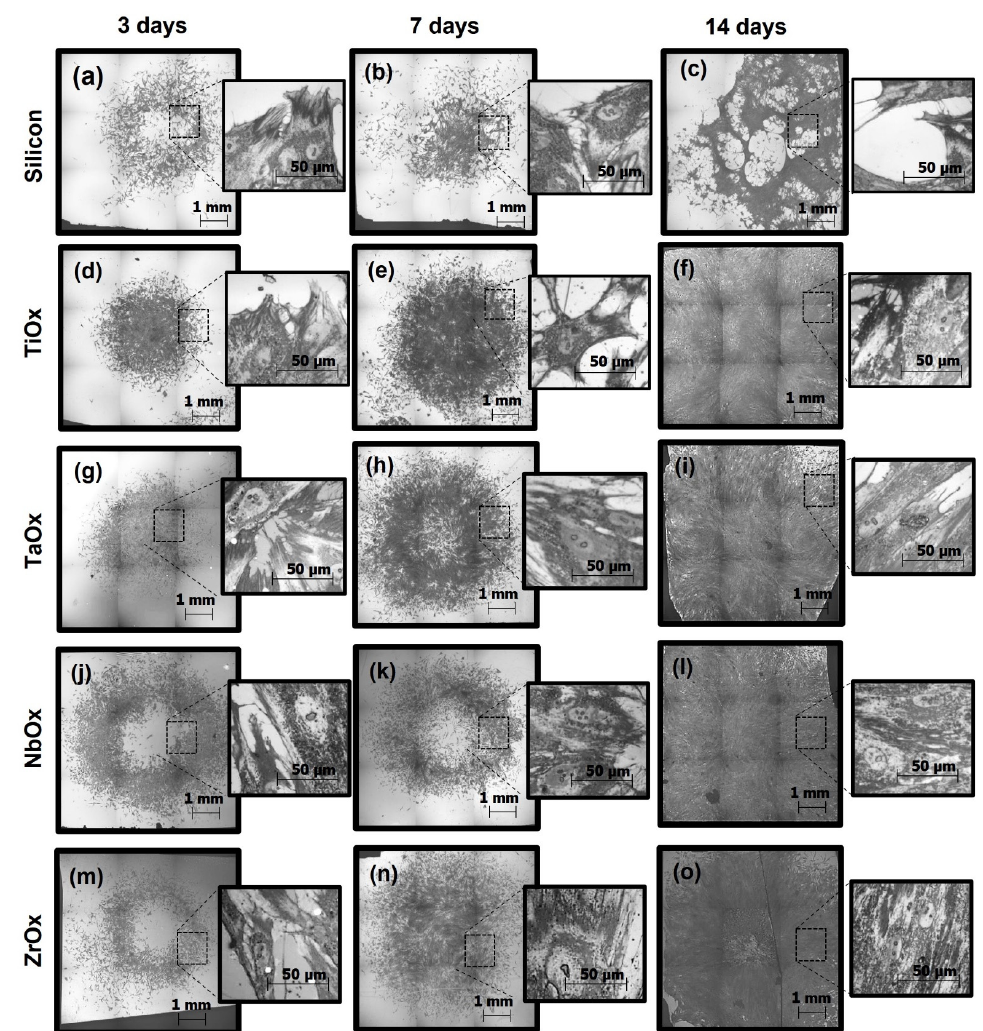
Figure 5. Representative micrographs, obtained by an optical profilometer, of BM-MSC cell cultured on uncoated Si ( a – c ) and coated, TiOx ( d – f ), TaOx ( g – i ), NbOx ( j – l ), and ZrOx ( m – o ), samples. Three incubation times were handled, 3, 7, and 14 days. Micrographs were acquired at two different mag- nifications, 5× for main micrographs and 50× for insert magnifications. Figure 6 presents a qualitative evaluation of cell viability by the LIVE/DEAD ® fluo- rescence assay. Viable cells are marked in green, and dead cells are marked in red. Upon cell culture on uncoated Si samples, cells were viable; however, they presented a more rounded morphology and became easily detached from the surface compared to the cells cultured on the coatings. In addition, a smaller number of viable cells and a higher number of dead cells were observed at all culture times on Si compared to the coatings. Upon